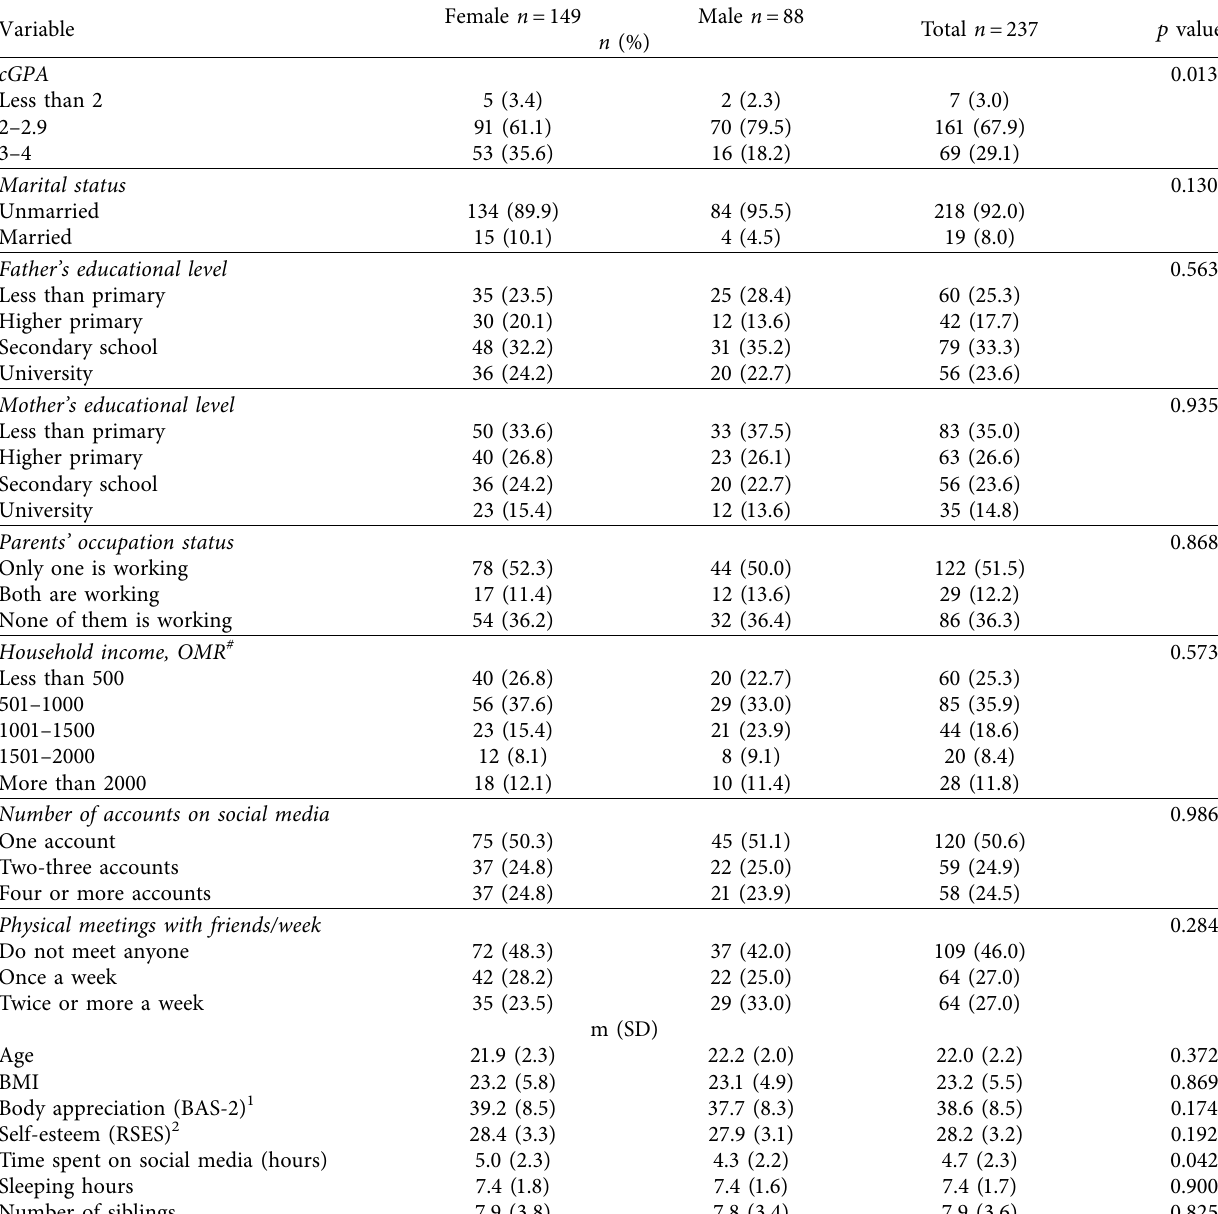
Table 1: Characteristics of the participants based on gender and presented in column percentages, n (%), and mean (standard deviation).